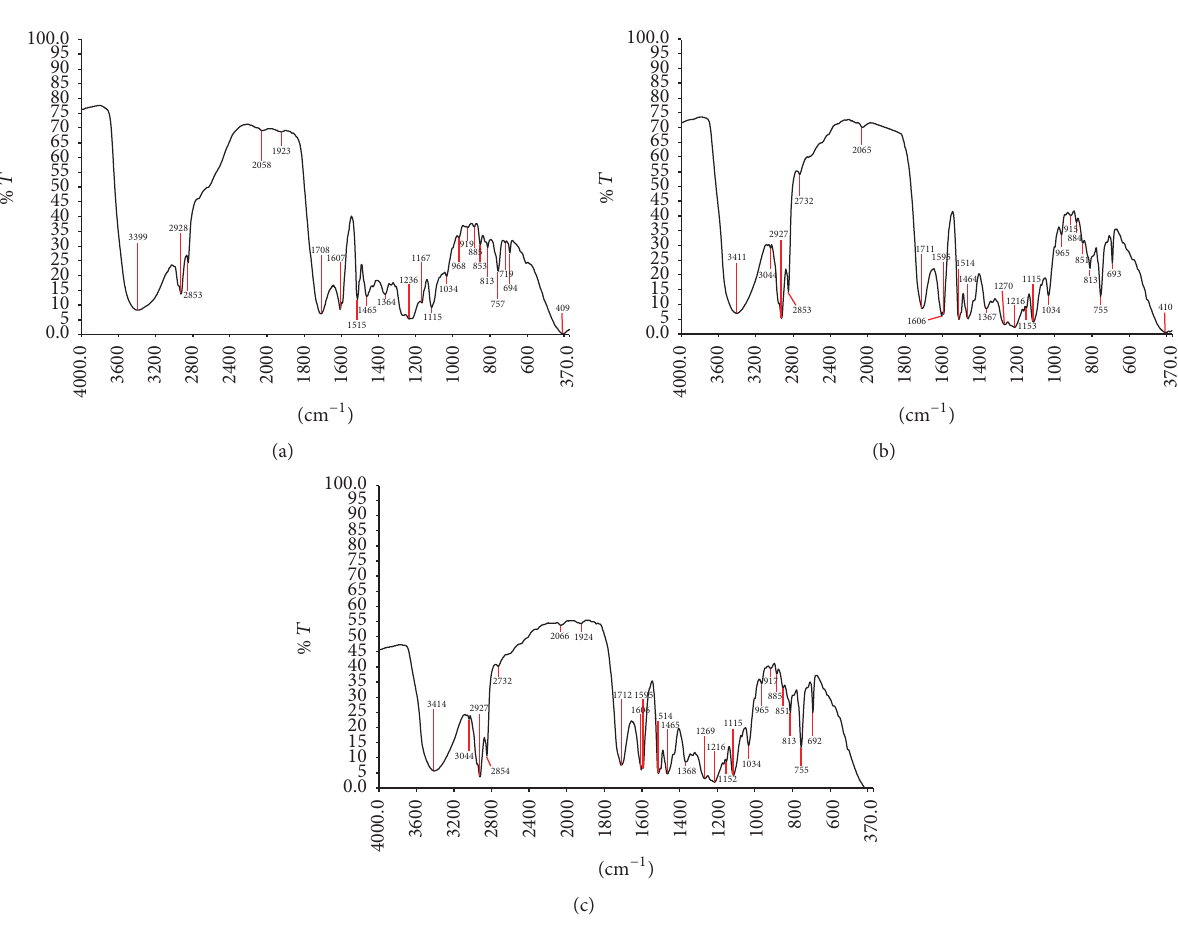
The pH value of EO was assuaged from 3.37 to